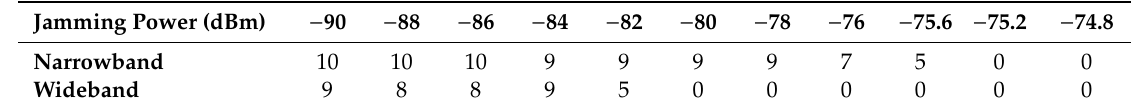
Table 3. Minimum number of available GPS satellites.